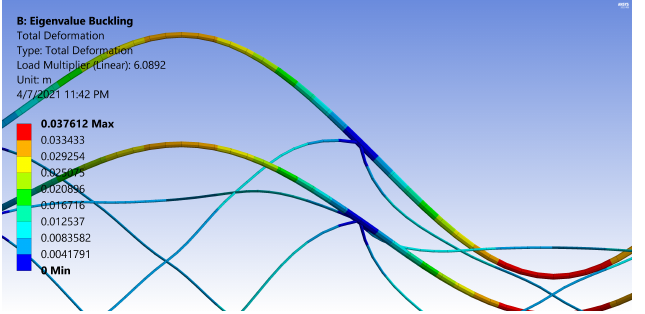
Figure 20. Rotation at the nodes of an IsoTruss structure with two carbon tows per helical mem- ber [26].